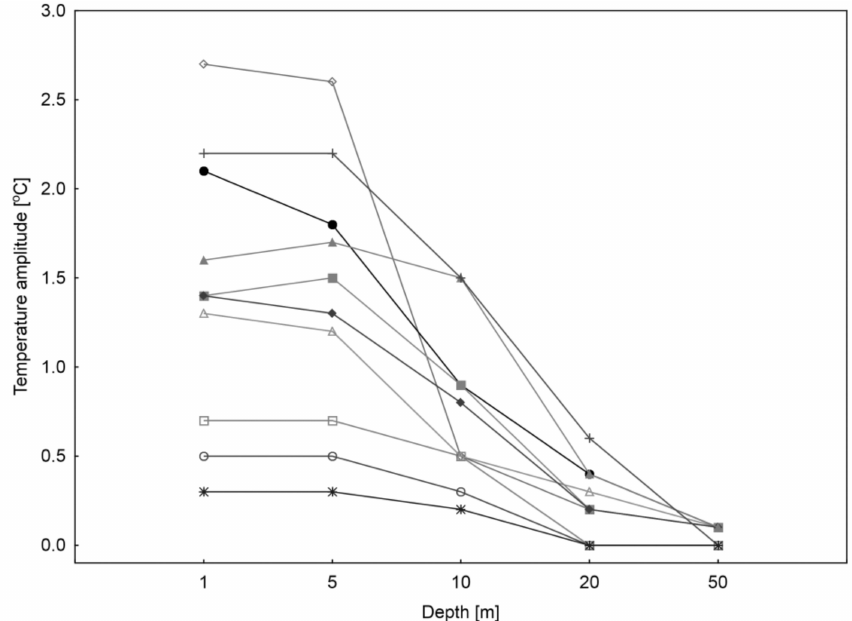
Figure 10. Correlation between water temperature amplitude and depth in Lake Morskie Oko. Temperature profile Type 5. The dates for each line are described in detail in the text above.